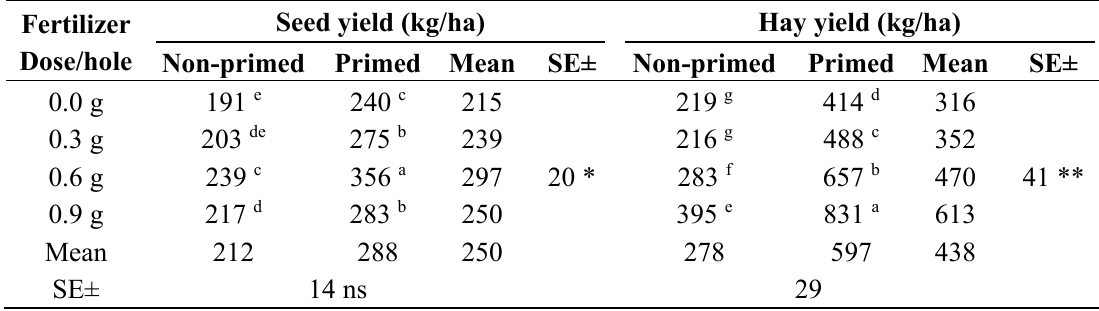
Table 9. Effect of seed priming and micro-dosing on cowpea seed and hay yields (kg/ha), combined across two